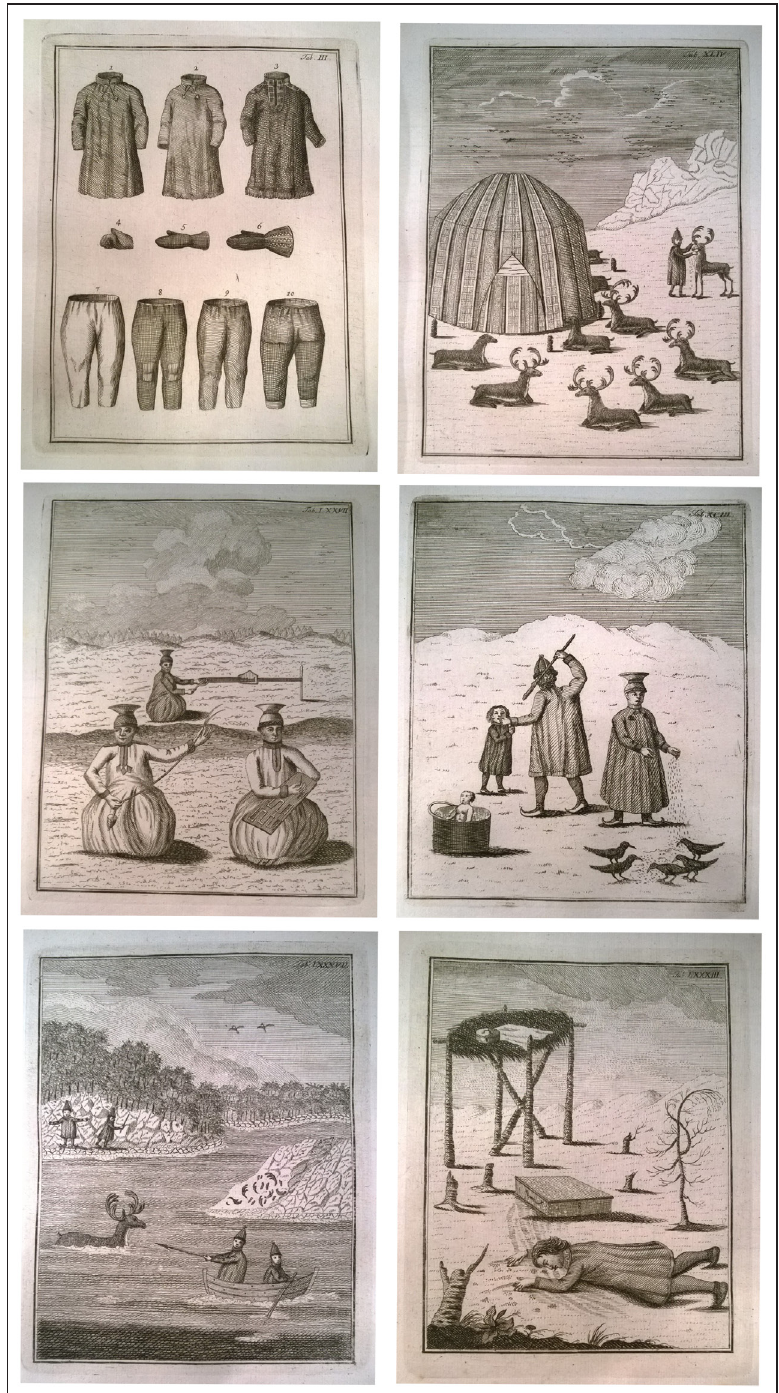
Figure 1: Plates 3, 44, 77, 93, 87, 83, depicting Sámi culture from the Norwegian priest Knud Leem’s Beskrivelse over Finmarkens lapper, deres tungemaal, levemaade og forrige afgudsdyrkelse (Description of Finmark’s Lapps, their language, way of life and earlier idolatry),